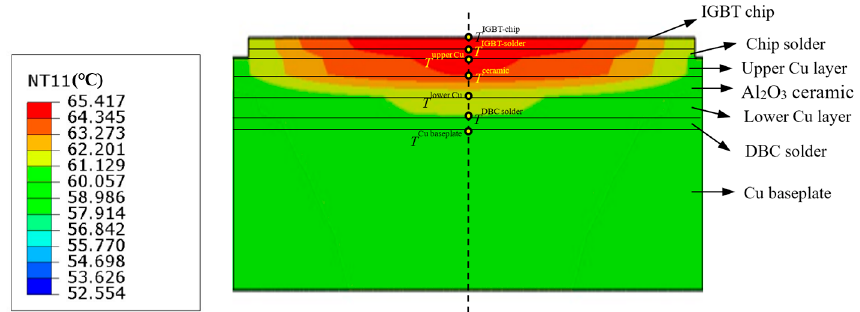
Figure 15. Temperature monitoring points on the IGBT-2 chip heat flow path.